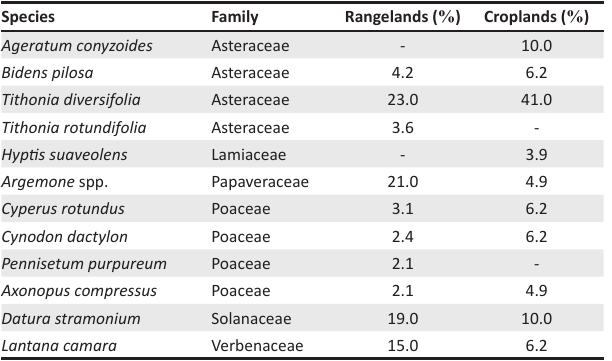
TABLE 2: Percentage of respondents ( n = 166) who selected a particular weed species as having the largest negative impact on either rangelands or crops in the Copperbelt province, Zambia.